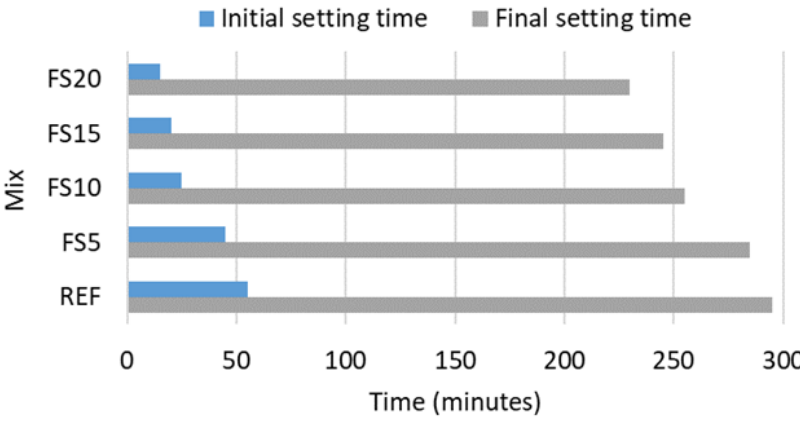
Figure 9. Initial and final setting times of mortars.